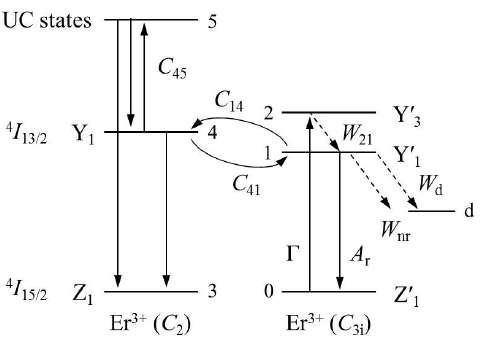
Figure 7. Energy diagram for the rate equation analysis compose of the ground (Z 1 , Z (cid:48) excited (Y 1 , Y (cid:48) , Y (cid:48) ), and the UC 3 1